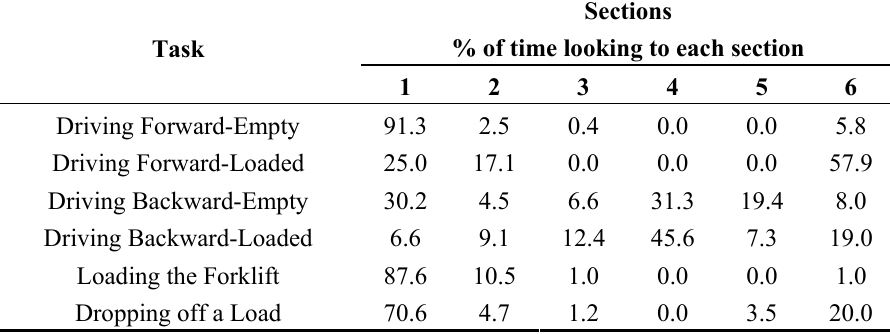
Table 2. Percentage of time looking to each section by task. Each task was repeated three times and the average percentage of time is shown. The section number coding is explained in the legend of Figure